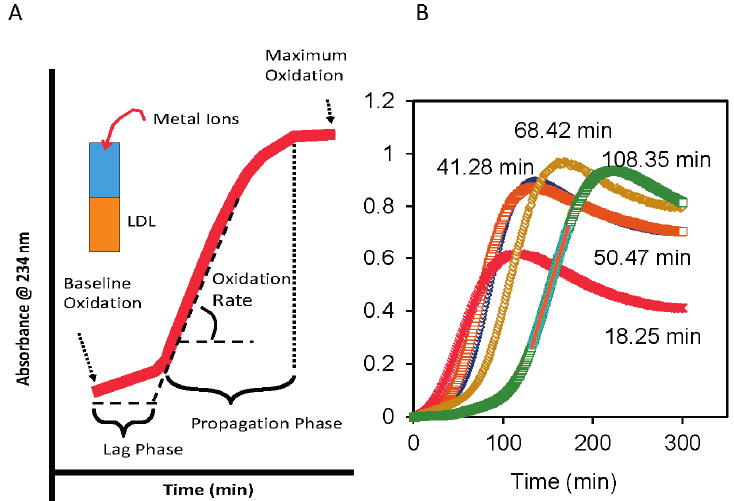
Figure 1. Oxidative susceptibility of plasma Low-Density Lipoproteins (LDL) in the presence of Cu 2+ as catalyst. ( A ) Kinetics of conjugated dienes formation as assessed by absorbance (234 nm) include three phases: Lag phase, propagation phase and degradation phase. Degradation phase is characterized by loss of signal after the maximum oxidation is reached; and ( B ) Under comparable incubation conditions, the lag phases for LDL isolated from fasting plasma of different individuals can vary widely from 18 to 108 min.